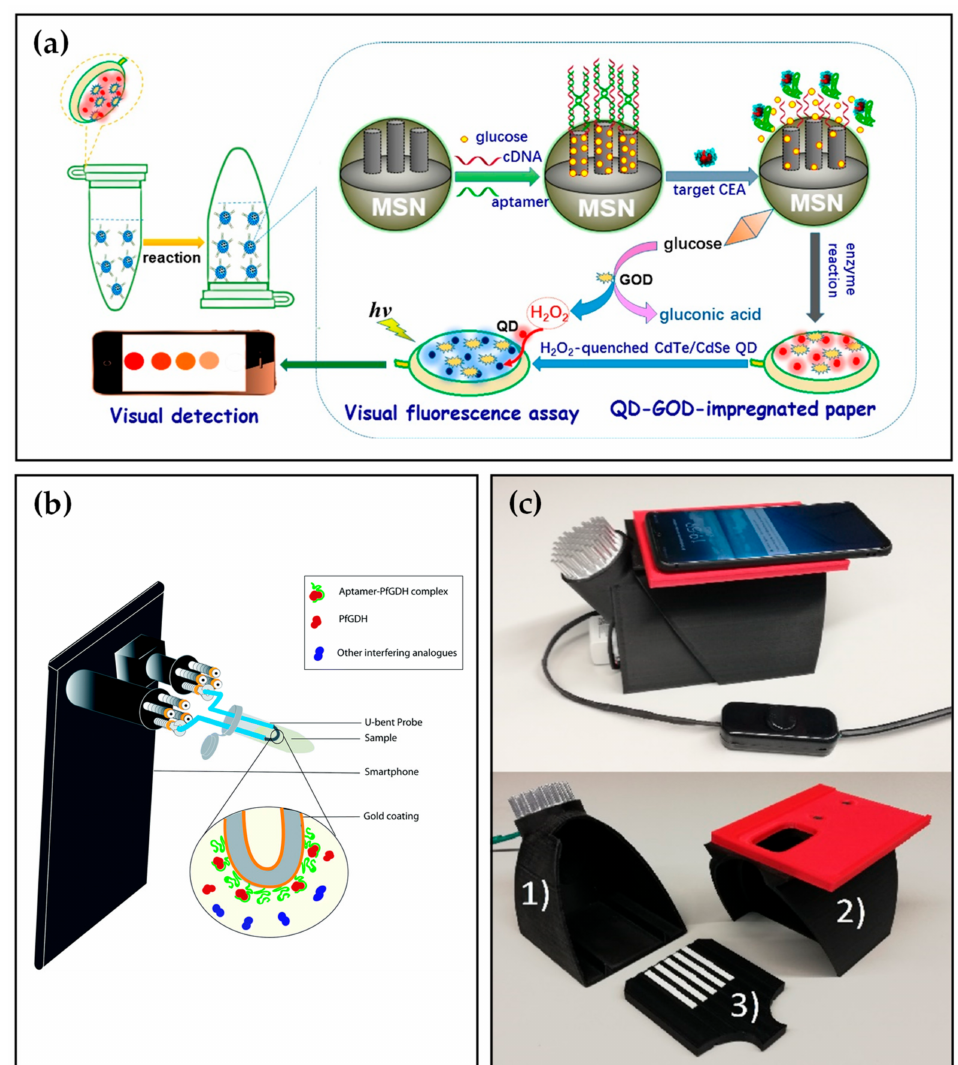
Figure 4. ( a ) Visual fluorescence detection mechanism of CEA biomarker based on paper-based ana- lytical device (PAD). Reprinted with permission from Ref. [88], copyright 2017, American Chemical Society. ( b ) Schematic illustration of the smartphone-based optic fiber platform. Reprinted with permission from Ref [92], copyright 2020, RSC Publishing. ( c ) Smartphone dark box comprising (1) a bottom part fitted with a UV-LED light source, (2) a lid fitted with a replaceable smartphone adapter, and (3) a sample plate for seven lateral flow strips. Reprinted with permission from Ref [94], copyright 2021,